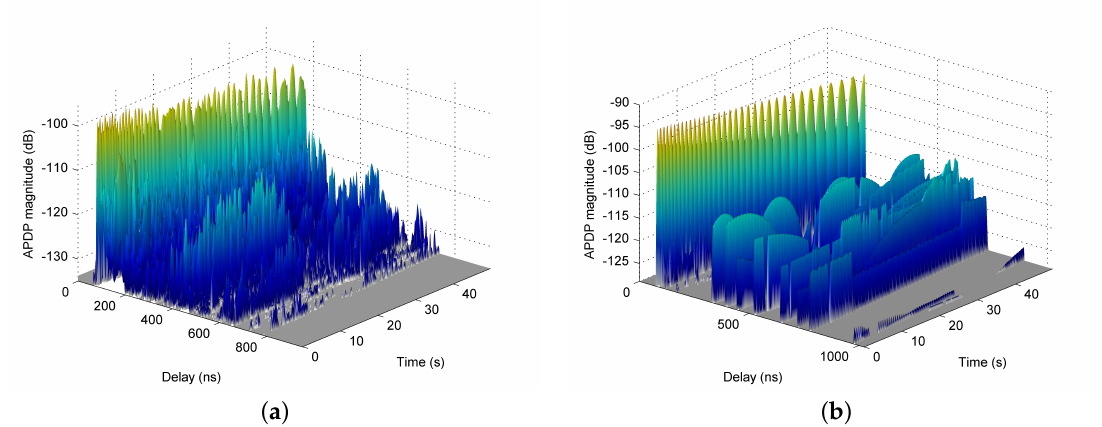
Figure 3. Evolution of averaged power delay profiles (APDPs) over time for TX position Tx1 and mobile RX on Track Rx1 from ( a ) measurement and ( b )